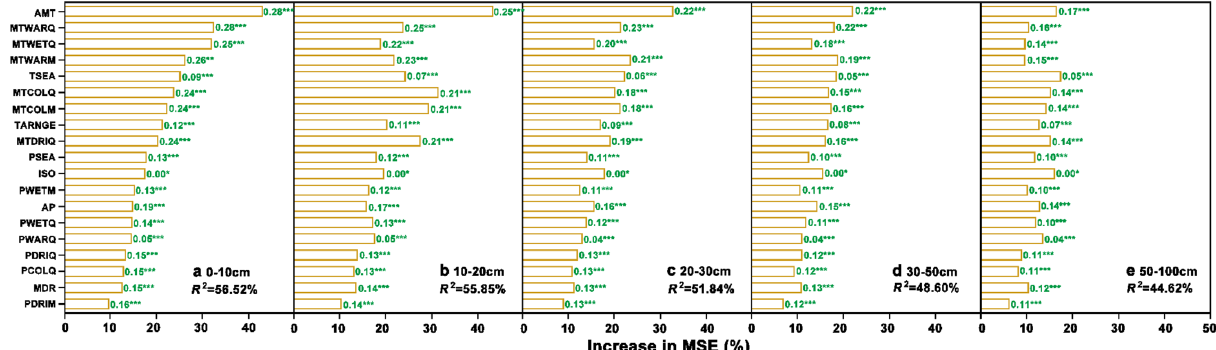
Figure 5. Relative contribution and Pearson’s correlations of climate factors as drivers of soil total P in different soil layers ( a – e ). Results from random forest analyses aiming to identify the main temperature and precipitation predictors of soil total P concentration. The increase in the mean square error (MSE, %) is displayed along the x-axes. Pearson’s correlations (green font) indicate the relationships between 19 bioclimatic variables and soil